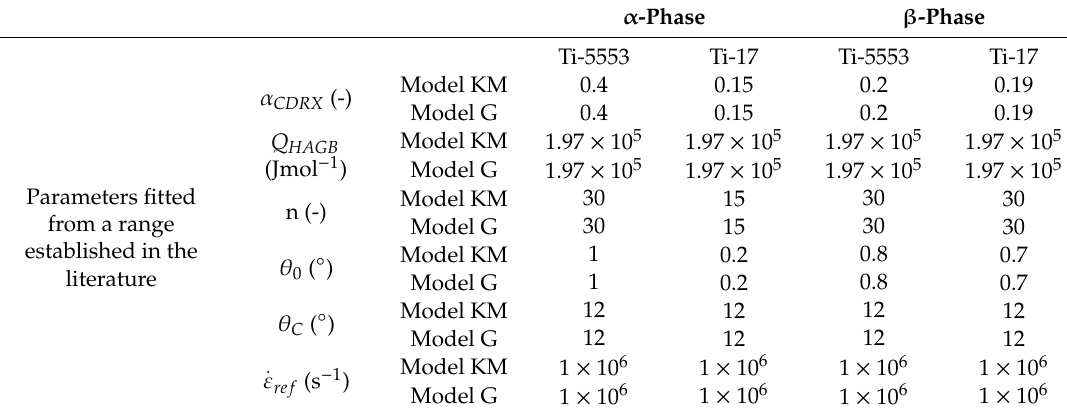
Table A3. Parameters adjusted according to a range established in the literature and used in the developed model.